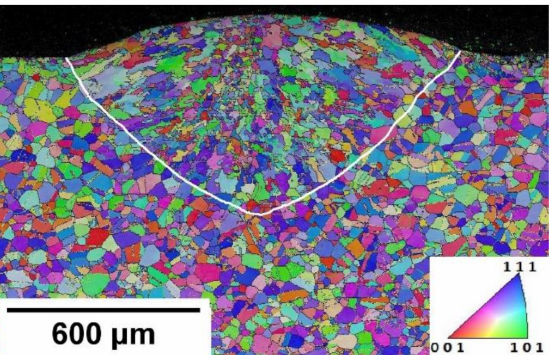
Figure 5. WPH condition EBSD map of Inverse Pole Figure (IPF) colored orientation image map with Pole Figure (PF)